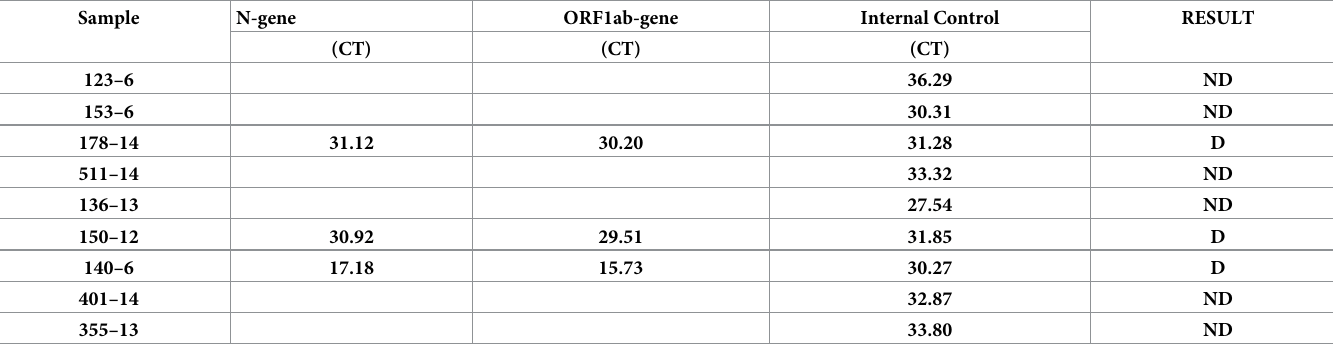
Table 7. RT-qPCR assay (example of a real case).